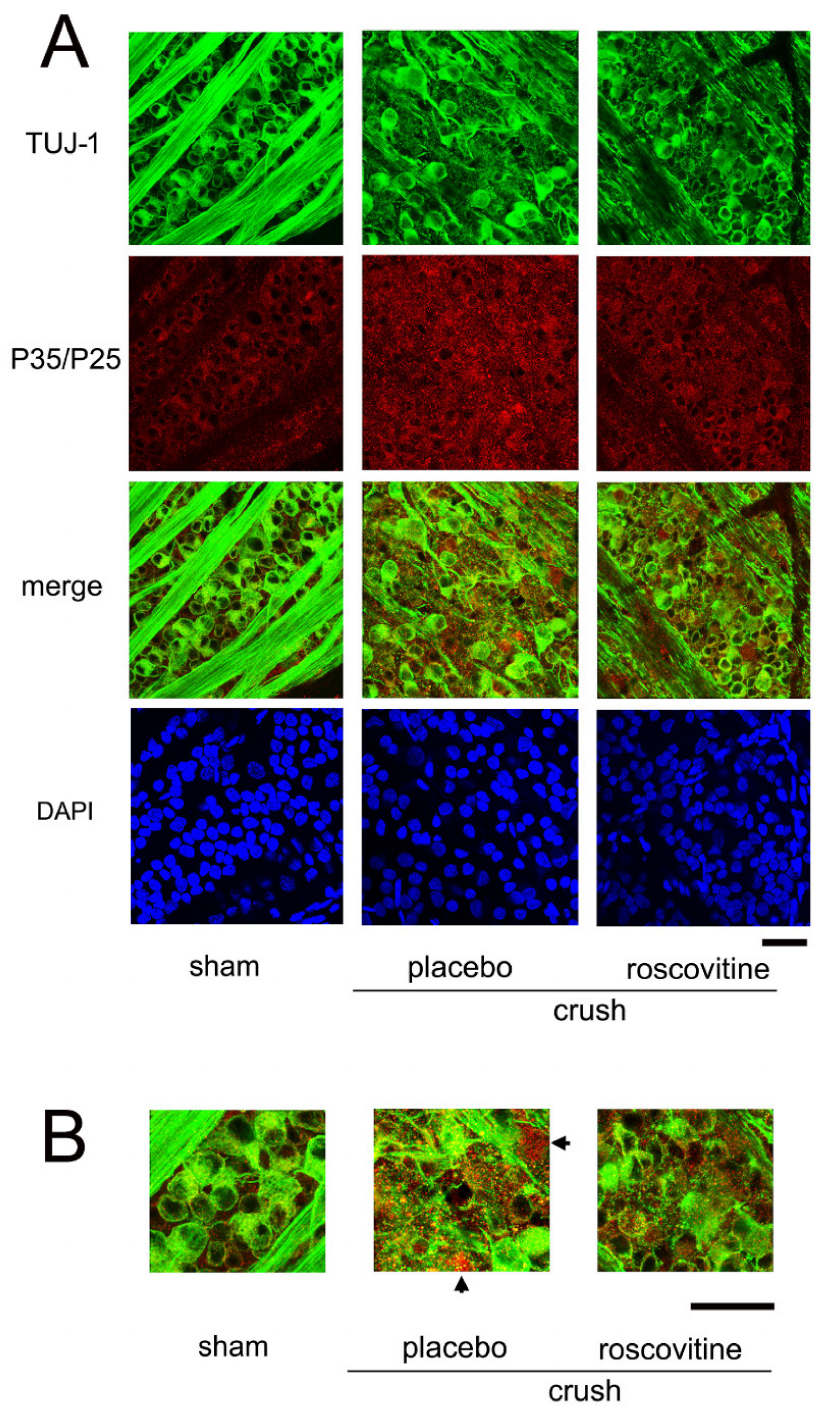
Figure 5. Representative confocal images of flat-mounted retinas demonstrating effects of roscovitine on the changes in the Tuj-1 and P35/P25 proteins. ( A ). Double labeling for Tuj-1 and P35/P25 in each group is shown. P35/P25 immunopositive granules are distributed unevenly with higher intensities after ONC (placebo). ( B ). Merged images are shown with higher magnification. P35/P25 immunopositive granules are accumulated in the dying RGCs where immunoreactivities to Tuj-1 are lost in the placebo group (arrows), while immunoreactivities to P35/P25 are less intense in the roscovitine-treated group. (Bar = 100 µ